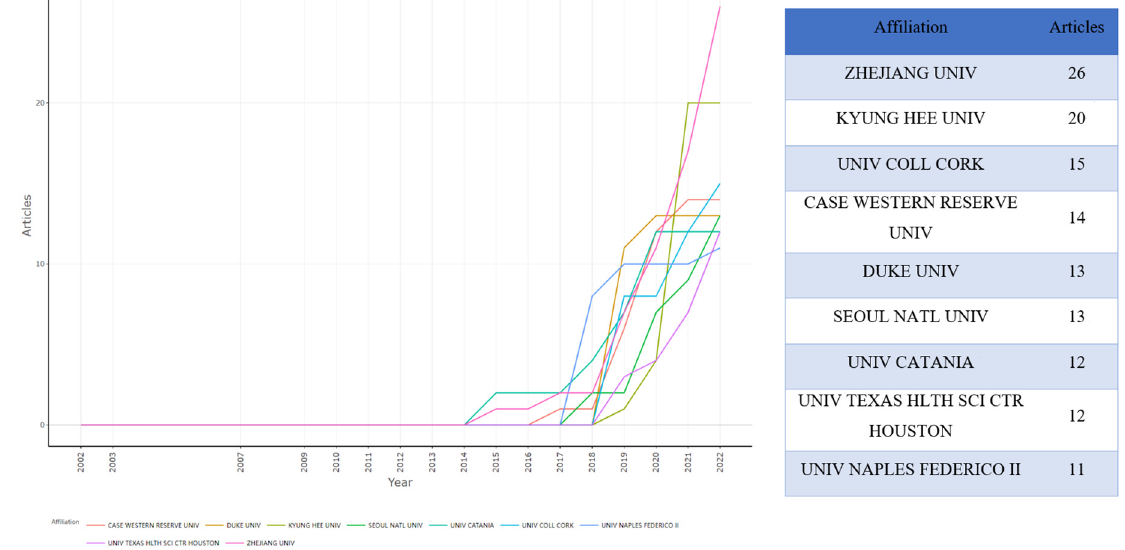
Figure 5. Top 9 contributing institutions and production over time on microbiome–gut–brain axis and dementia-related research.